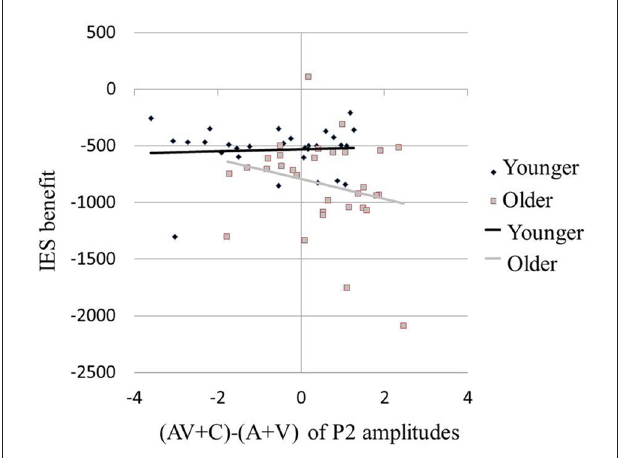
FIGURE 4 | Between-group comparison of the event-related potential (ERP) waveform in the FC2 electrode. (A) ERP waveform of younger participants in four conditions (A, V, AV and C), which shows typical P1, N1 and P2. (B) Waveform of older participants in four conditions (A, V, AV and C), which shows typical P1, N1, and P2. (C) ERP amplitude differences of [(AV + C) − (A + V)] among the younger and older participants. The older participants show super-additive patterns, while the younger participants show sub-additive patterns. (D) P2 mean amplitude comparison between the two groups. The older participants showed more negative amplitude in all conditions compared to the younger participants. The older participants also showed more negative amplitude in the AV + C condition, while the younger participants showed more negative amplitude in the A + V condition.